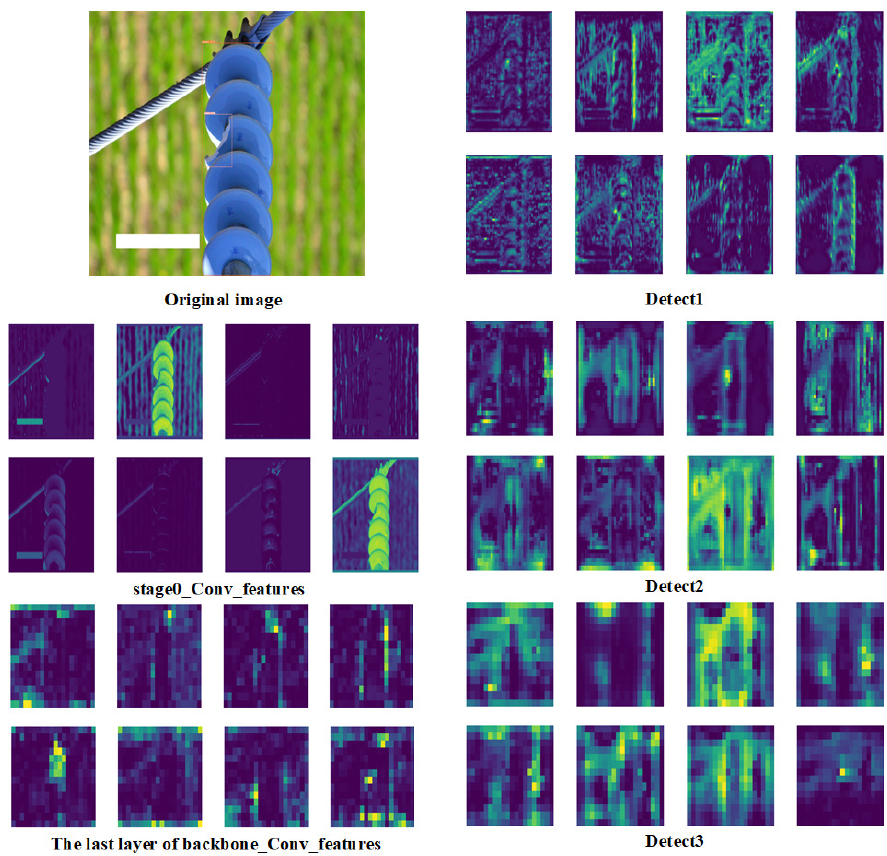
Figure 10. Visualization of the feature